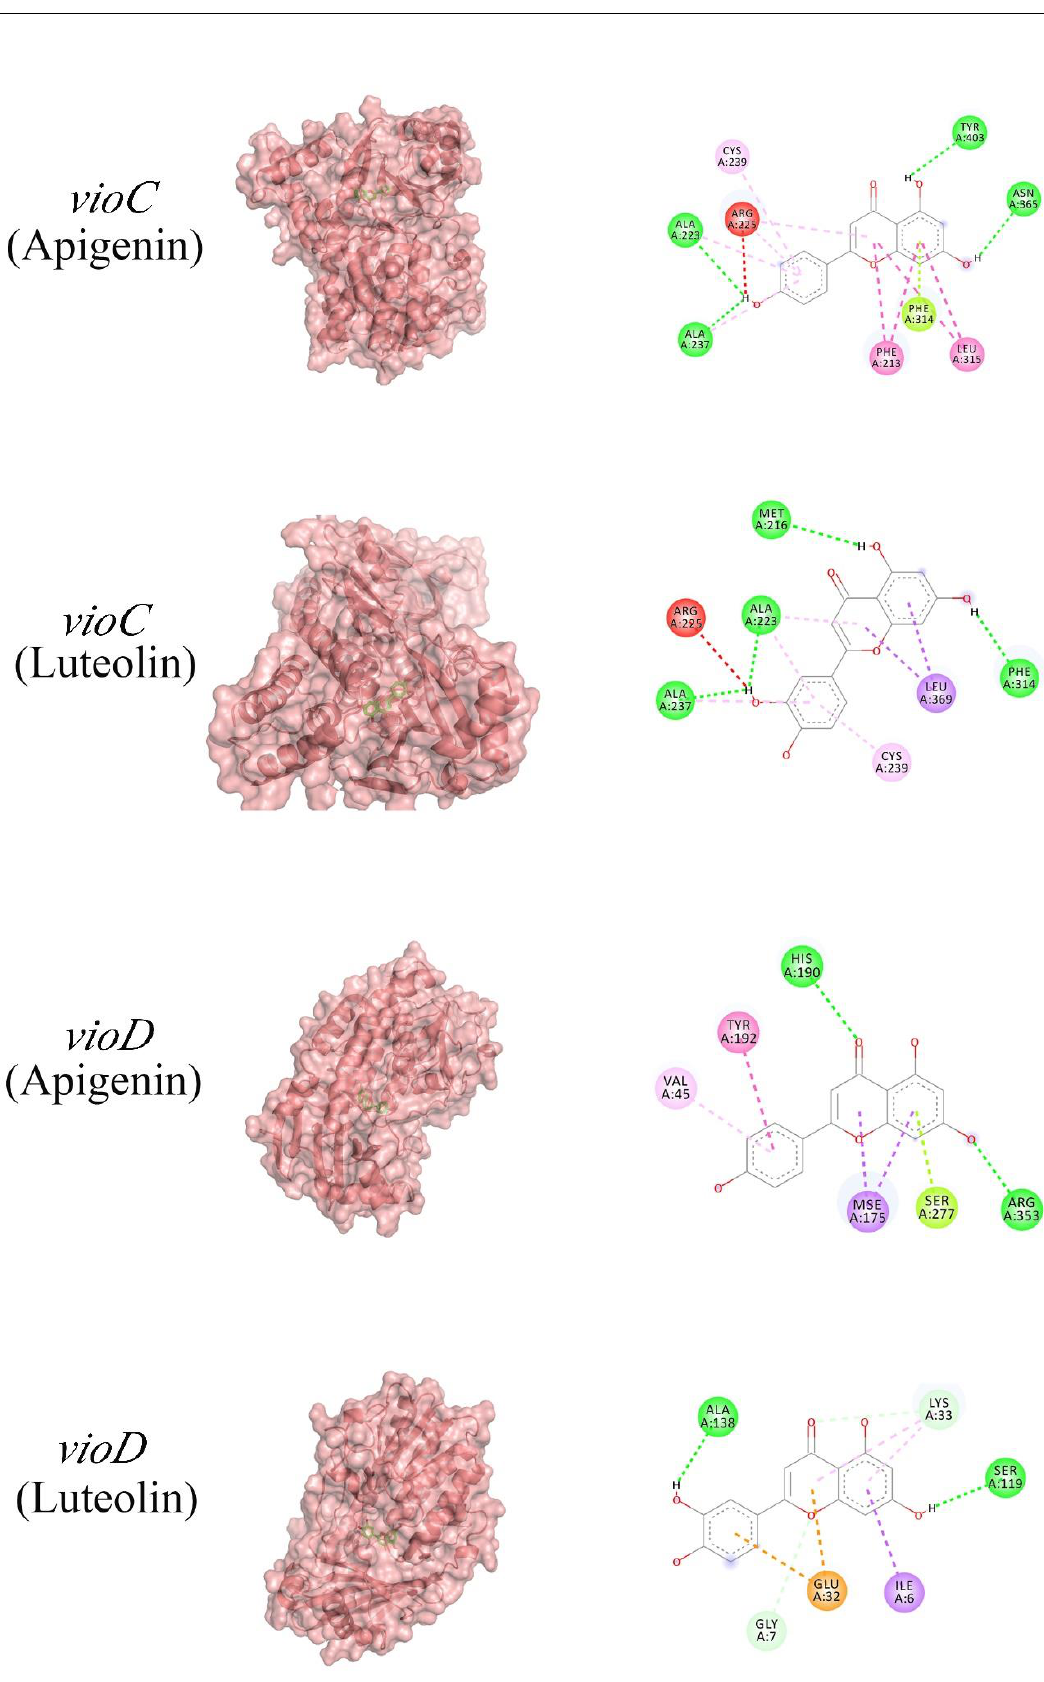
Figure 7. Molecular docking prediction map. The left side is the three-dimensional structure of the connection position, and the right side is the label of the specific binding site.